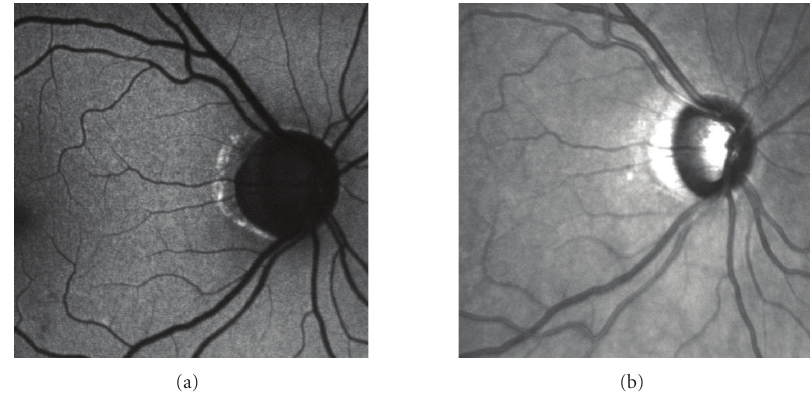
Figure 1: (a) AF and (b) IR